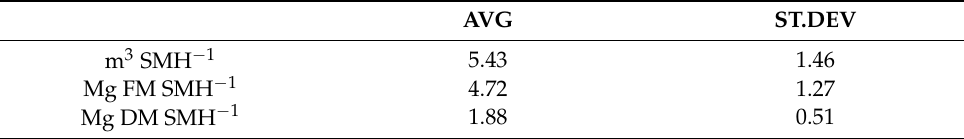
Table 2. Productivity SMH (including delays) of felling